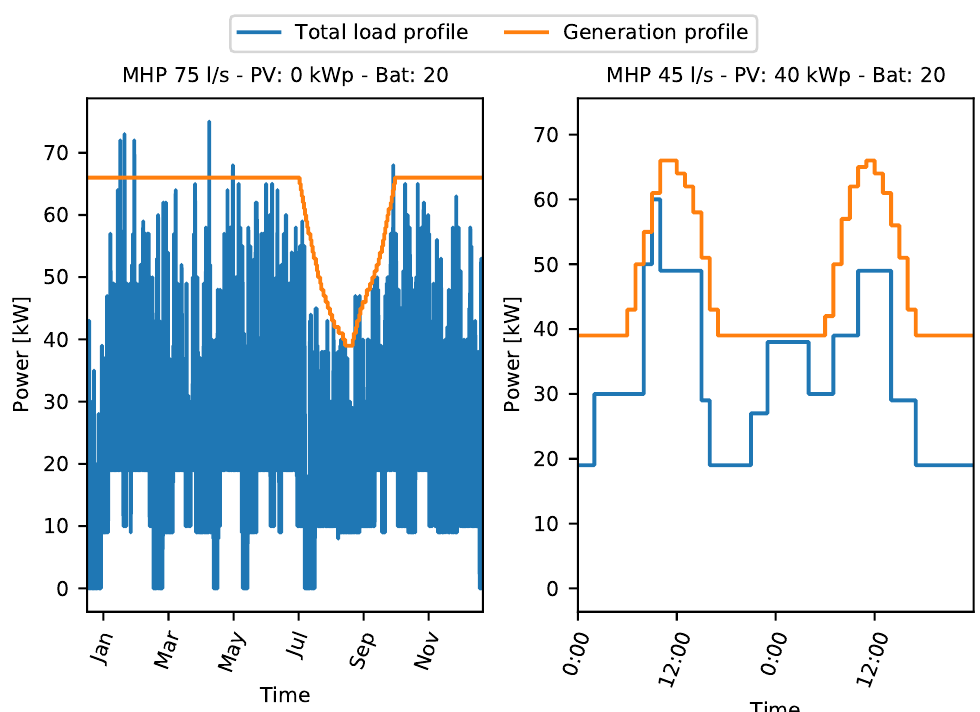
Figure 9. Exemplary segment of load and generation profiles after scheduling for the whole year ( left ) and detailed view of one day ( right